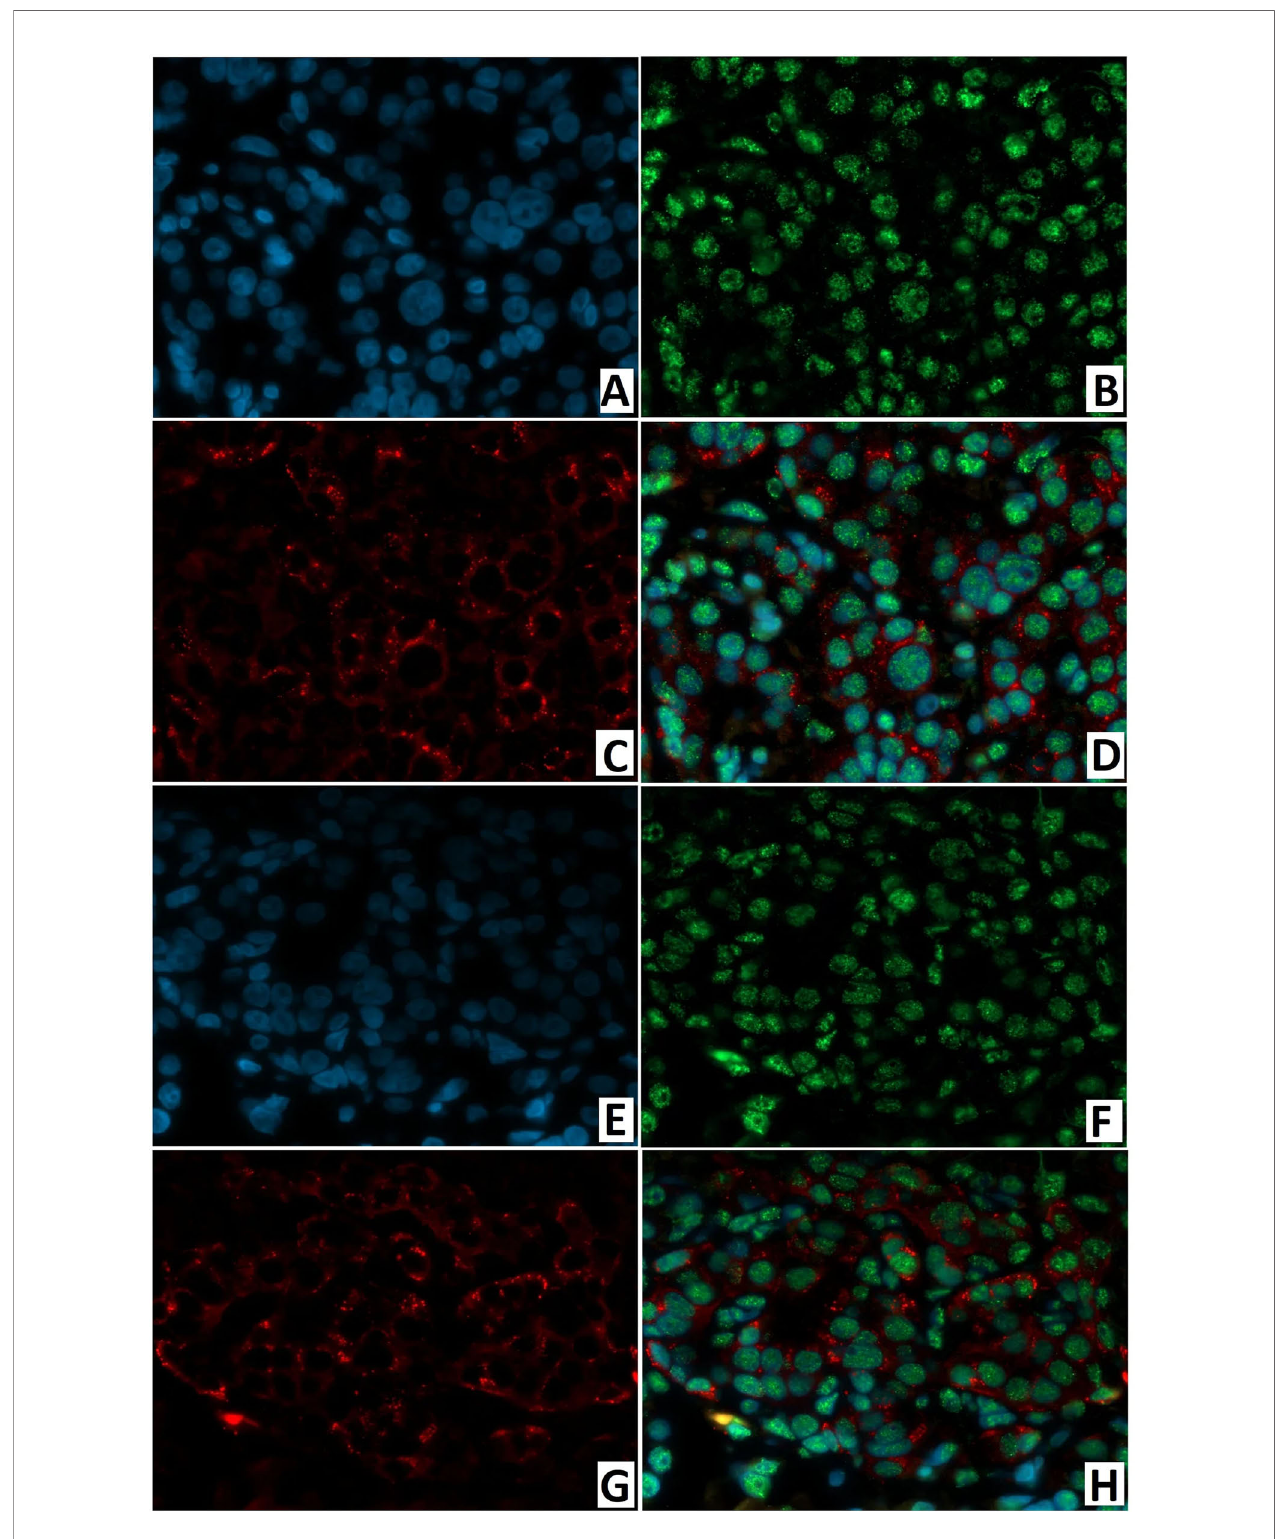
FIGURE 14 | Confocal laser scanning microscopy of the pancreas in congenital hyperinsulinism. (A – D) focal form, (E, F) diffuse form. (A, F) blue fl uorescence of cell nuclei (DAPI). (B, F) green fl uorescence of NeuroD1 in nuclei. (C, G) red fl uorescence of ChrA in cytoplasm. (D, H) greenish-blue/turquoise fl uorescence of NeuroD1 and red fl uorescence of ChrA in the same cells;